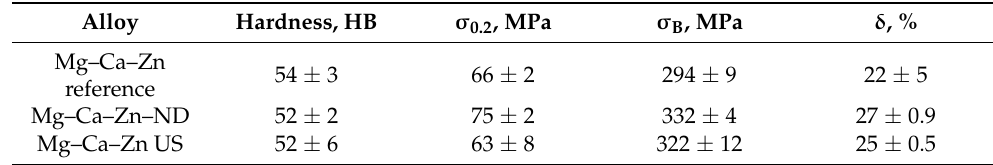
Table 2. Mechanical properties of the obtained magnesium